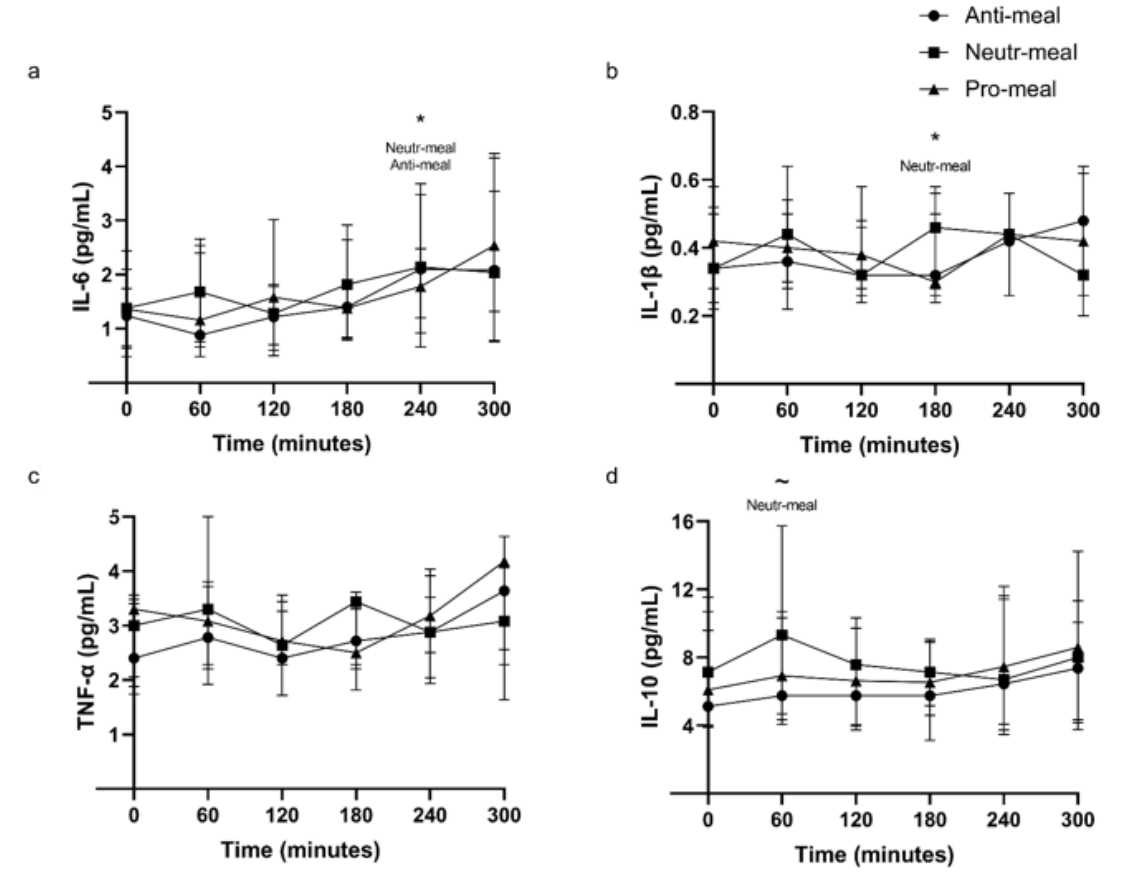
Figure 3. Postprandial plasma ( a ) IL-6, ( b ) Il-1 β , ( c ) TNF- α , and ( d ) IL-10 concentrations after ingestion of Anti-meal, Neutr-meal, or Pro-meal. Data are presented as median ± IQR ( n = 11), Friedman test followed by pairwise comparisons using Wilcoxon signed-rank test comparing iAUC between the test meals. * p < 0.05 and ~ p = 0.05 by Wilcoxon signed-rank test comparing peak with baseline concentrations within test meals. Abbreviations: Anti, anti-inflammatory; Neutr, neutral; Pro, proinflammatory. Table 4. Postprandial plasma IL-6, IL-1 β , TNF- α , and IL-10 measures for Anti-meal, Neutr-meal, and